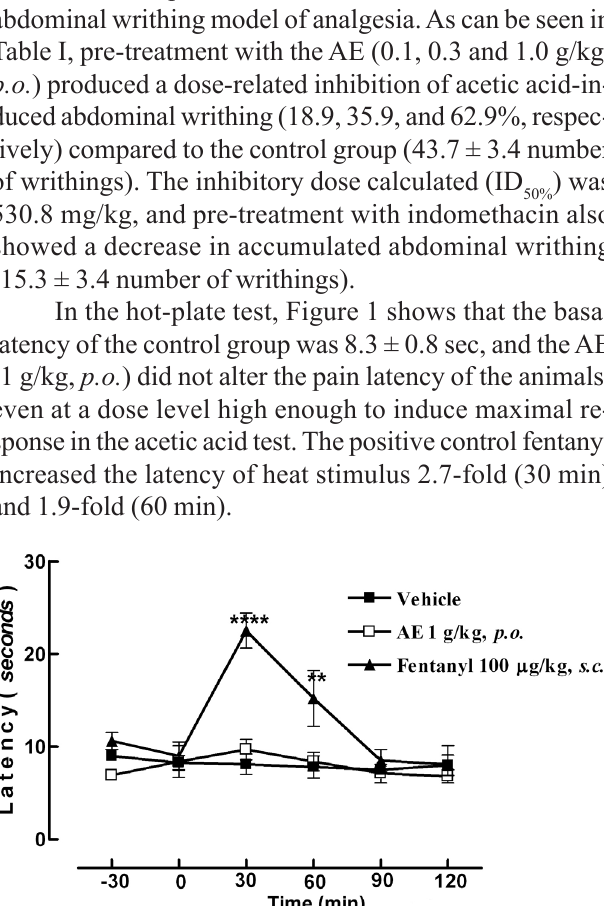
TABLE I - Effect of AE from Anacardium occidentale on acetic acid-induced abdominal writhing in mice Treatment ( p.o. )